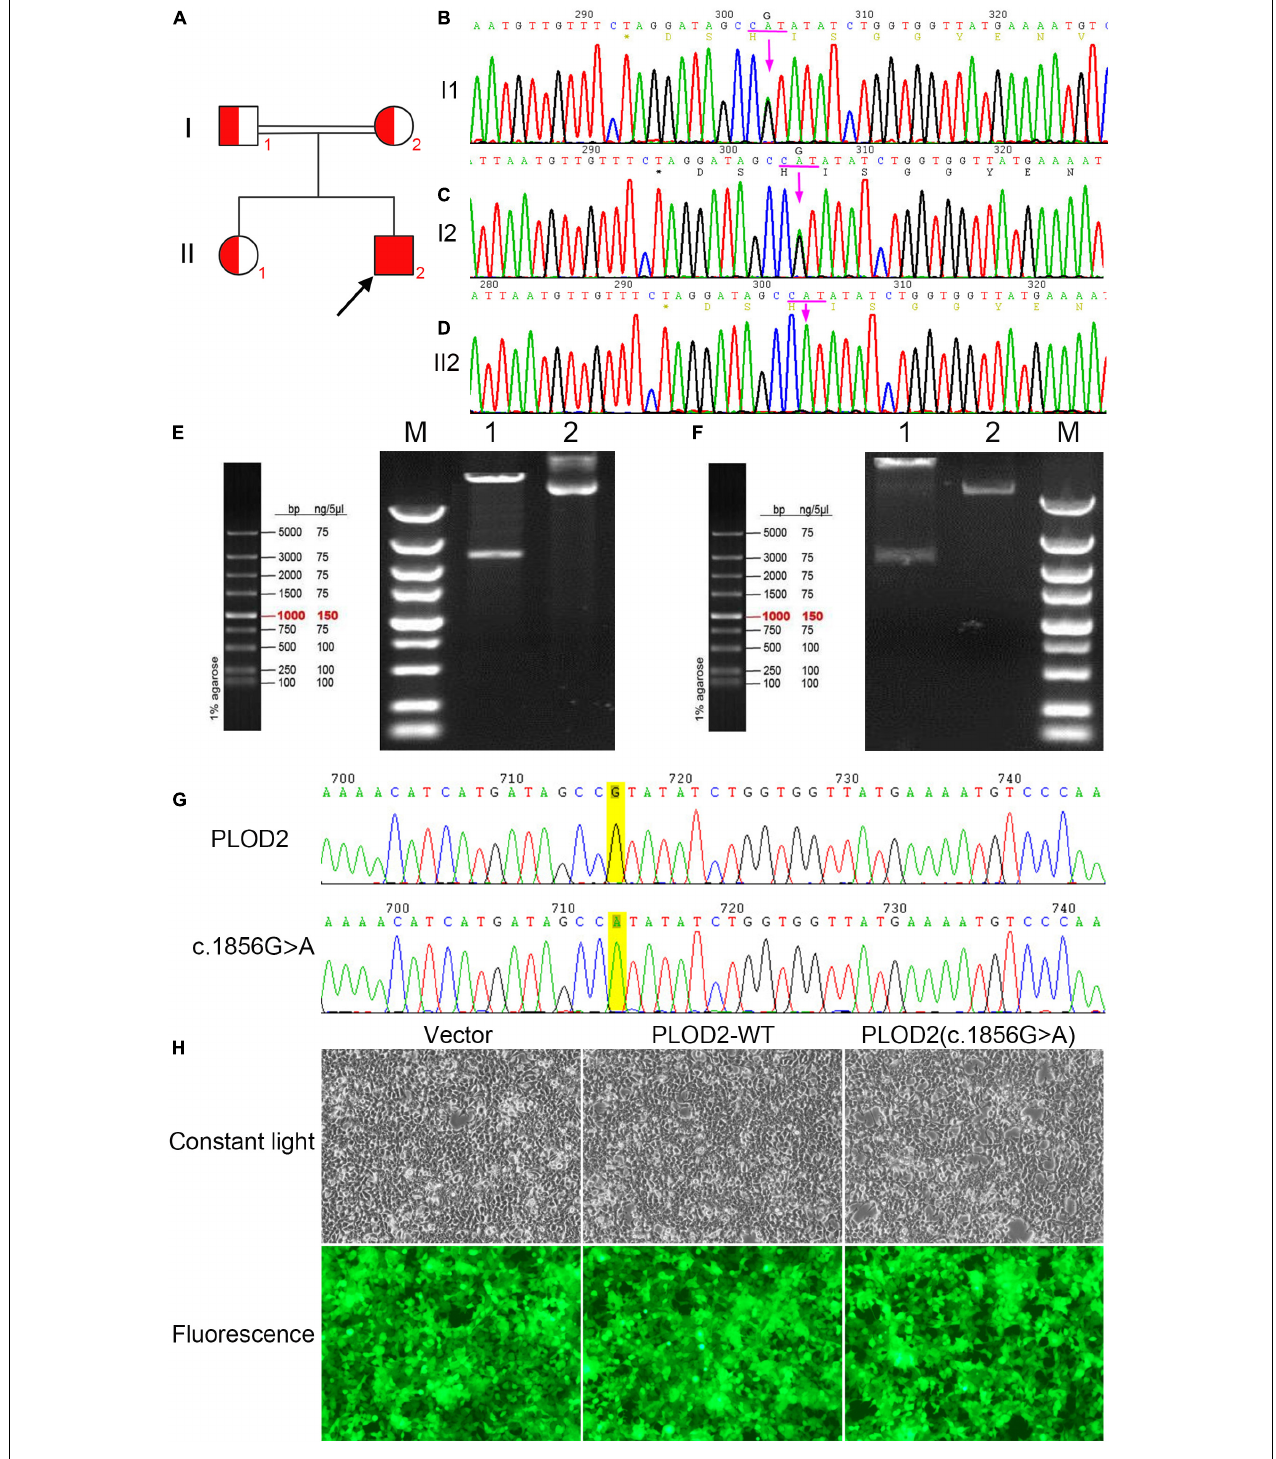
FIGURE 2 | (A) Bruck syndrome (BS) pedigree map; the proband (arrow) has a homozygous variant; red indicates carrying the c.1856G > A (p.Arg619His) variant of PLOD2 gene. (B,C) A heterozygous variant of c.1856G > A (p.Arg619His) in exon 17 of PLOD2. (D) A homozygous variant of c.1856G > A (p.Arg619His) in exon 17 of PLOD2. (E) The electrophoretic map of PLOD2 (c.1856G > A) clone plasmid digested by Xba I and Not I. Lane M, DNA Marker; Lane 1, plasmid digested by Xba I and Not I; and Lane 2, plasmid DNA. (F) The electrophoretic map of PLOD2 wild type clone plasmid digested by Xba I and Not I. Lane M, DNA Marker; Lane 1, plasmid digested by Xba I and Not I; Lane 2, plasmid DNA. (G) Sanger sequencing verification diagram of PLOD2 wild type and c.1856G > A clone plasmid. (H) The cell growth diagram after cell transfection showed that there was no significant difference in GFP transfection efficiency among the groups.